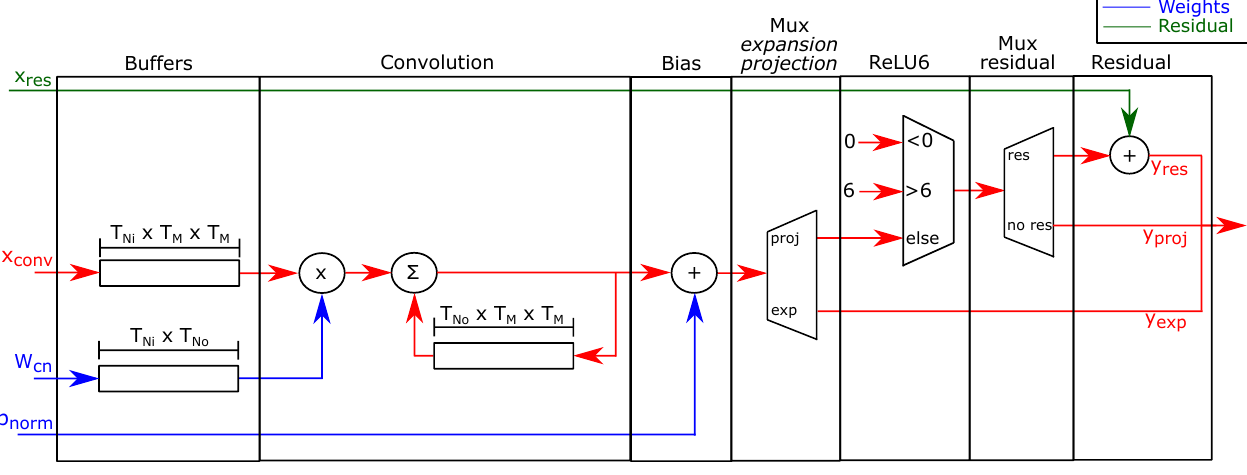
Figure 7. Expansion/projection